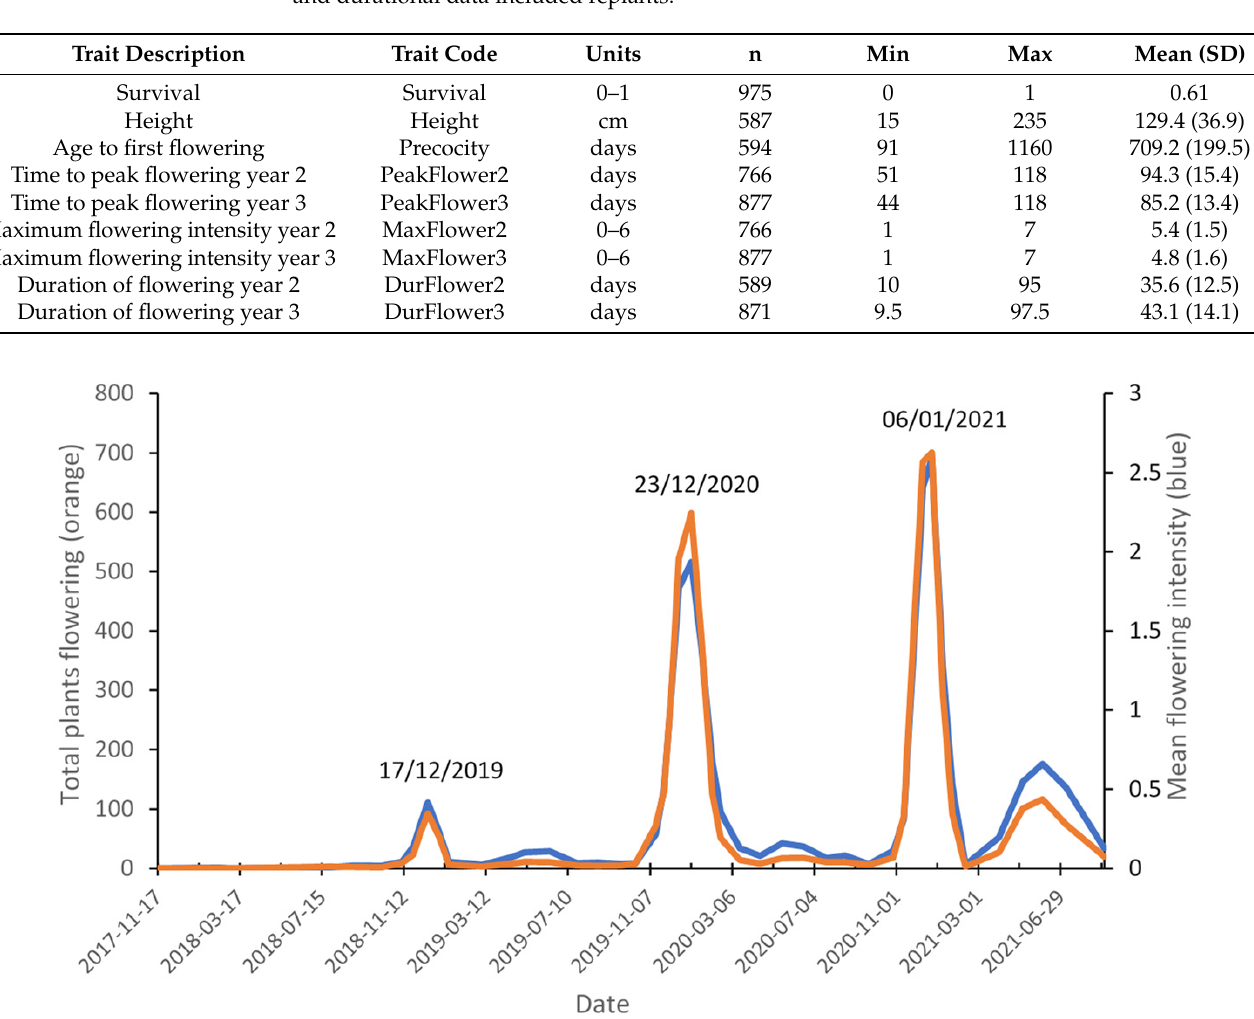
Figure 2. Total number of plants flowering and mean flowering intensity of Leptospermum scoparium over time in the first 3 years after plantation establishment. The main flowering peak each year occurs in summer (date indicated above each summer peak). Note that a secondary flowering peak also consistently formed in winter.